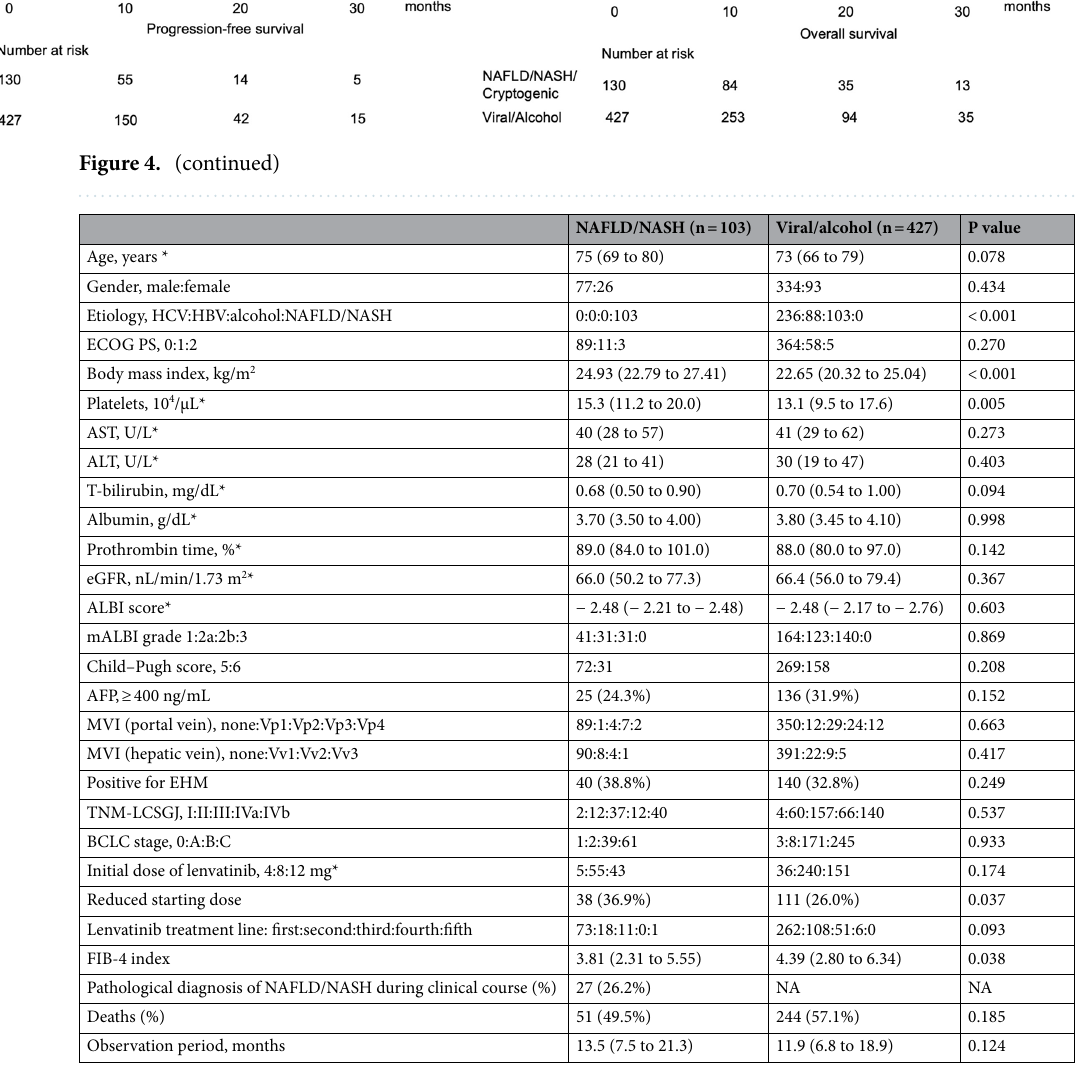
Table 2. Comparison of clinical features between NAFLD/NASH and Viral/Alcohol groups after exclusion of cryptogenic HCC. HCV hepatitis C virus, HBV hepatitis B virus, NAFLD non-alcoholic fatty liver disease, NASH non-alcoholic steatohepatitis, ECOG PS Eastern Cooperative Oncology Group performance status, AST aspartate transaminase, ALT alanine aminotransferase, ALBI score albumin-bilirubin score, mALBI grade modified ALBI grade, AFP alpha-fetoprotein, MVI macrovascular invasion, EHM extra-hepatic metastasis, TNM LCSGJ 6th tumor node metastasis stage by Liver Cancer Study Group of Japan 6th edition, BCLC stage Barcelona Clinic Liver Cancer stage, NA not applicable. *Median (interquartile